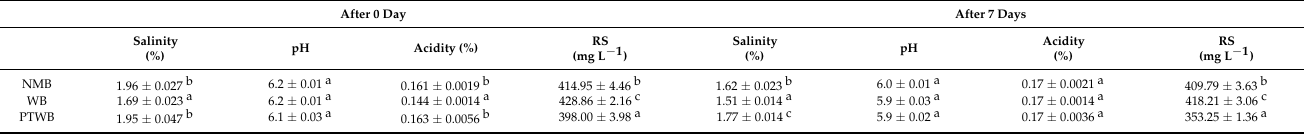
Table 4. The changes in 4 quality parameters of salted Kimchi